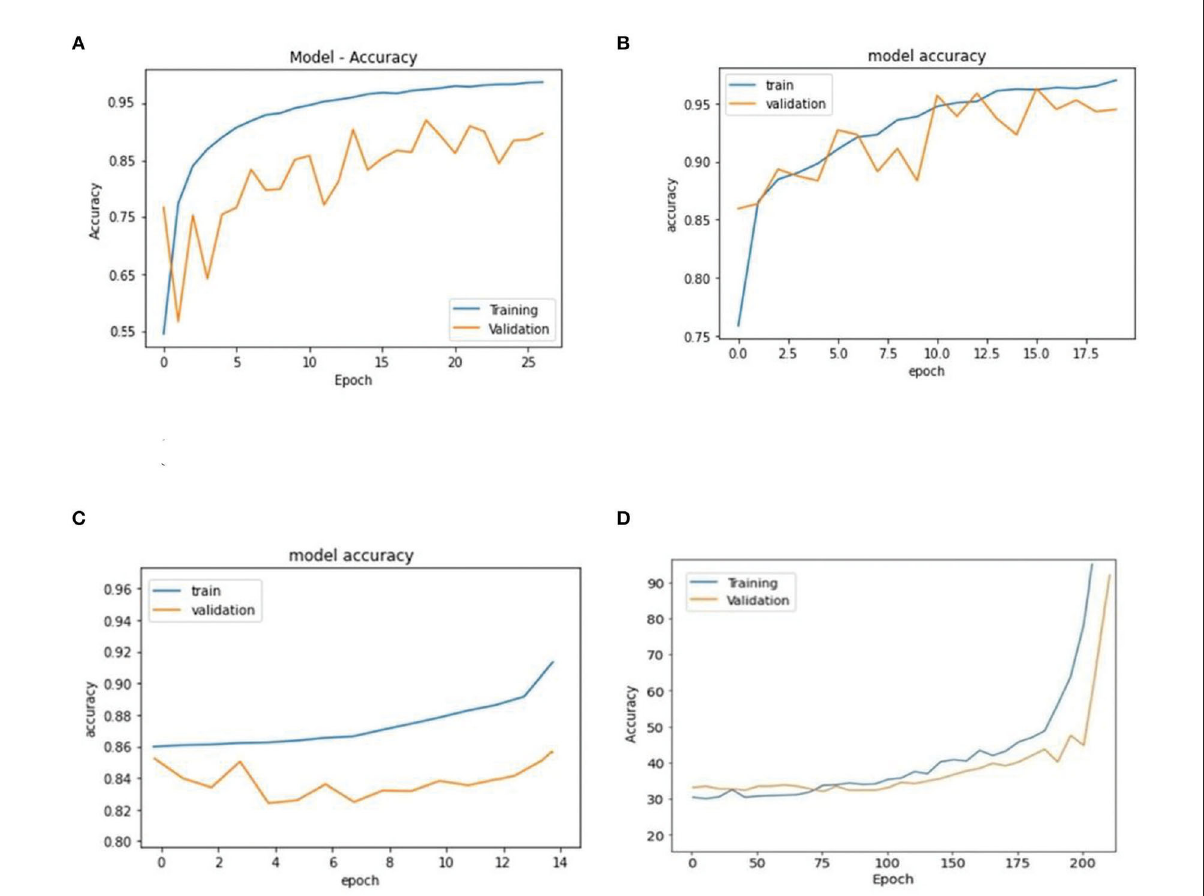
FIGURE5 Comparison of accuracy achieved during training and validation phases of LR, AdaBoost, SVM, and ensemble of AdaBoost and LR models (PTB-ECG dataset). (A) Logistic regression. (B) AdaBoost. (C) Support vector machine (SVM). (D) AdaBoost – logistic regression based ensemble